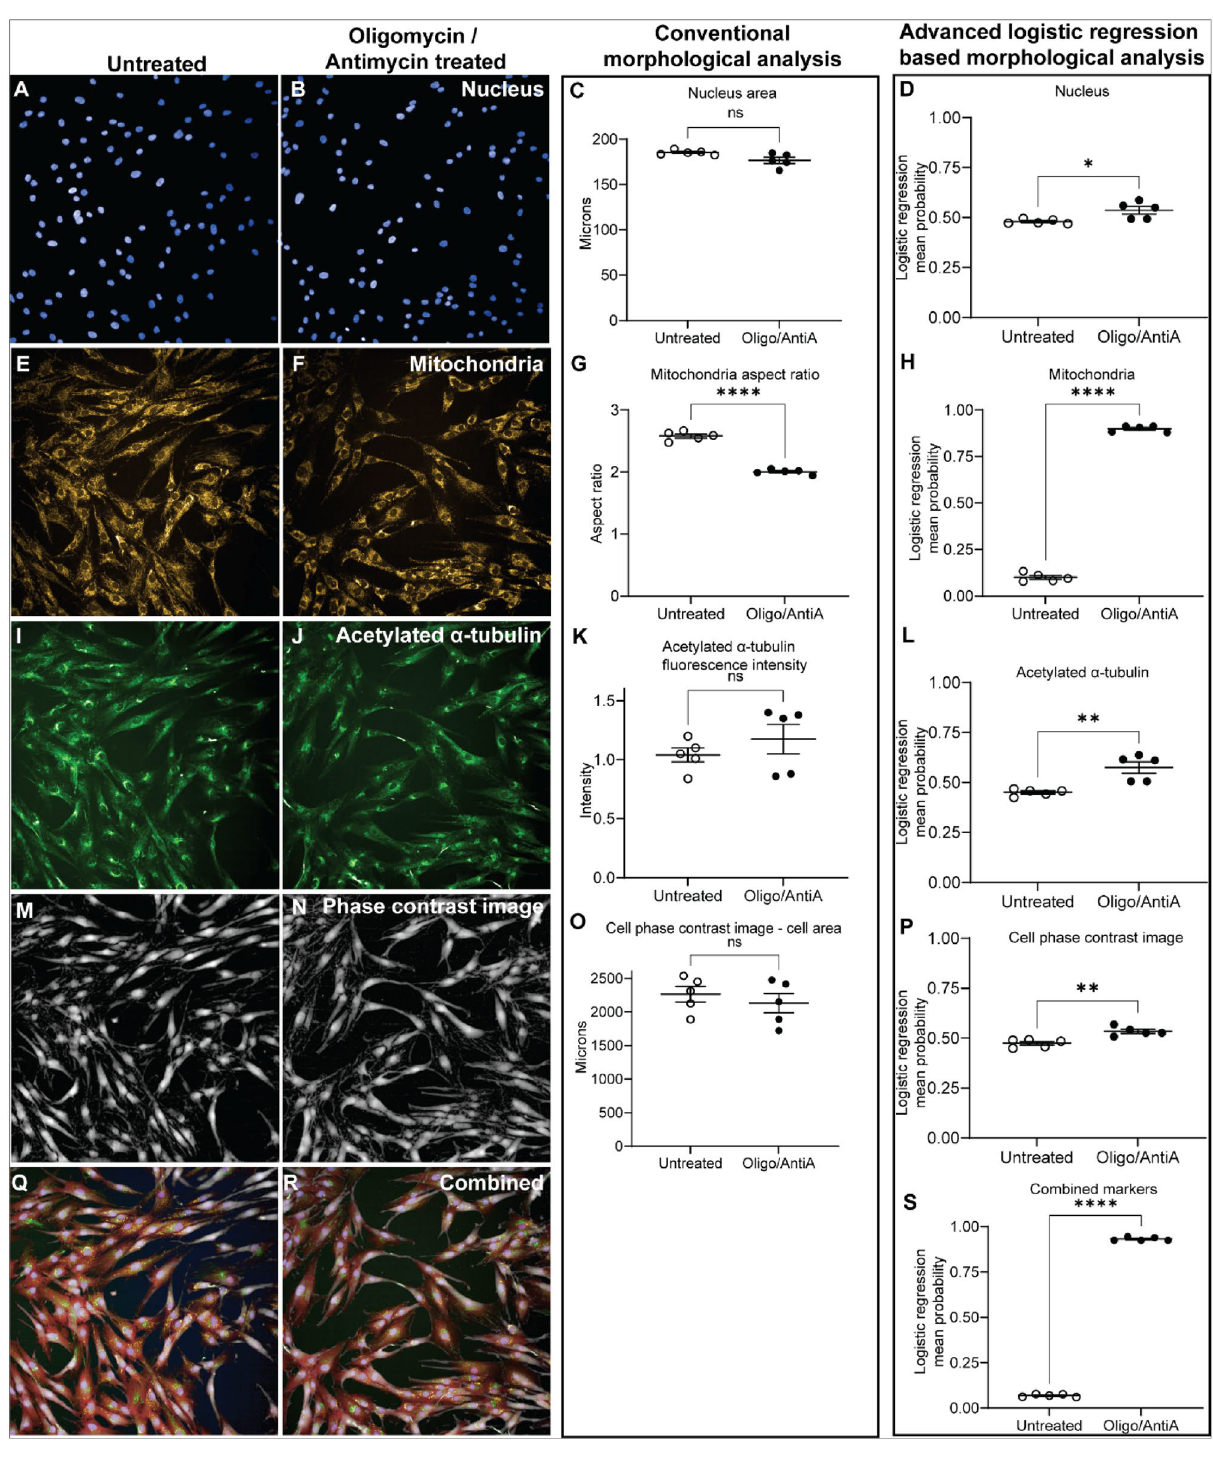
Figure 2. Conventional vs advanced image analysis approaches. We compared the two approaches using images of cells treated with mitochondria respirator chain inhibitors Oligomycin and AntimycinA. Images of cells labelled to identify cell nucleus ( A , B ), mitochondria ( E , F ), acetylated α-tubulin ( I , J ), label-free phase contrast cell images ( M , N ) and the combination of all markers ( Q , R ) were analysed. Conventional analysis identified differences in mitochondria morphology between the two cell groups (1.25 fold difference) ( G ) and did not identify any differences with the other markers ( C , K , O ). In contrast, the advanced image analysis approach identified an amplified mitochondria morphology difference of 9.80-fold between the two groups ( H ) and identified significant morphological differences in cell components: nucleus ( D ), acetylated α-tubulin ( L ), label-free phase contrast images ( P ) and the combination of all markers ( S ). Mean values were compared using students